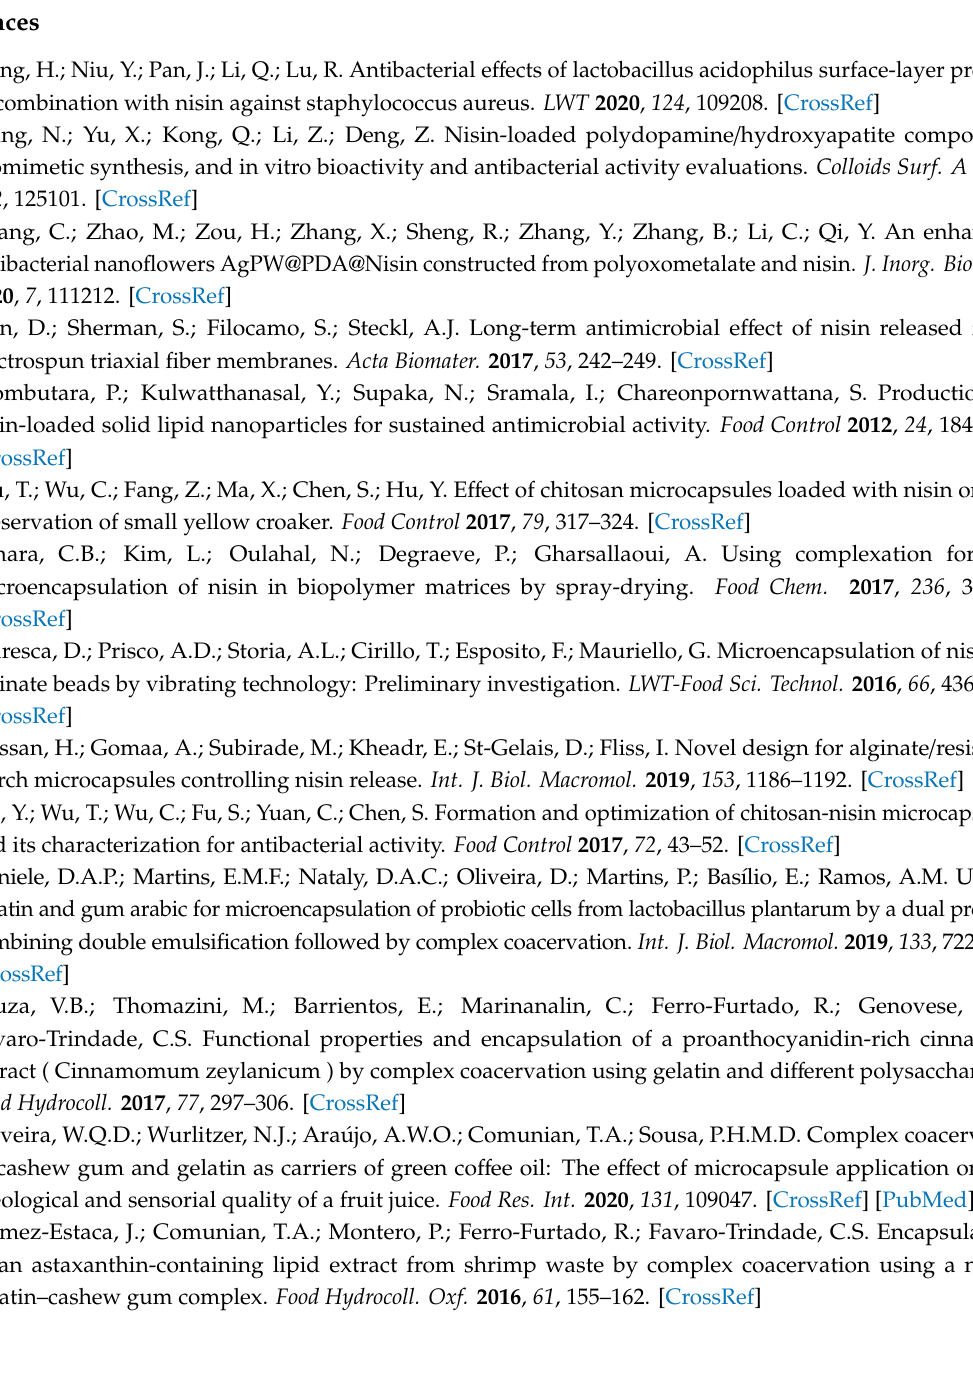
Table S1: Actual levels at coded factor levels of independent variables used in the RSM, Table S2: Experimental designs and results of the response surface methodology, Figure S1: Response surface plots and contour plots showing the e ff ects of pH (X 1 ), ultrasonic time(X 2 ) and E 1 / E 2 (X 3 ) on and encapsulation e ffi ciency and interactions between